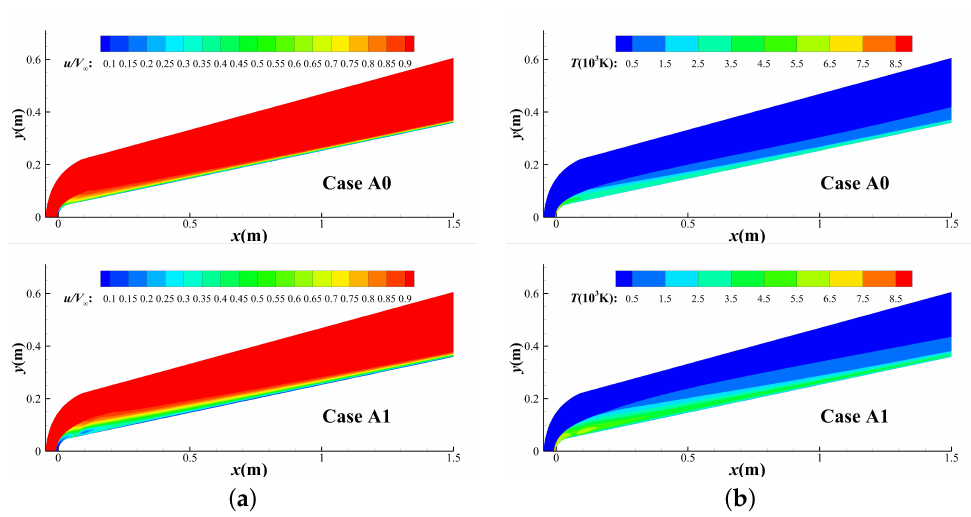
Figure 22. Comparison of flow fields with and without external magnetic field: ( a ) Streamwise velocity. ( b ) Temperature.